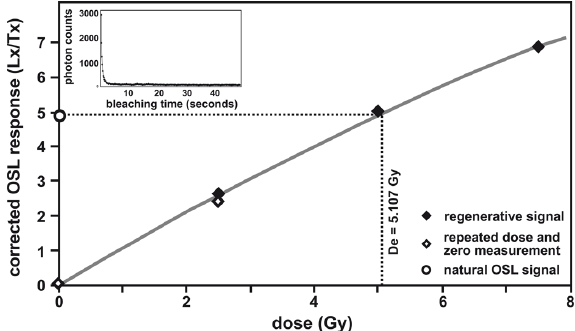
Fig. 6. Typical luminescence signal of the tsunamites of the study area (KPT 20/1a). Shine-down curve (upper left corner) and SAR growth